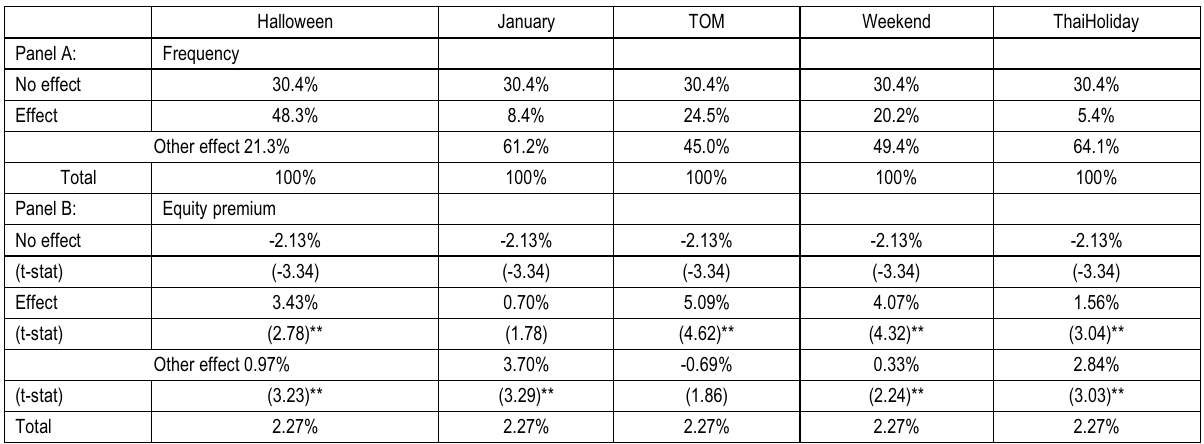
Table 3. The classification of Thailand equity risk premium with calendar